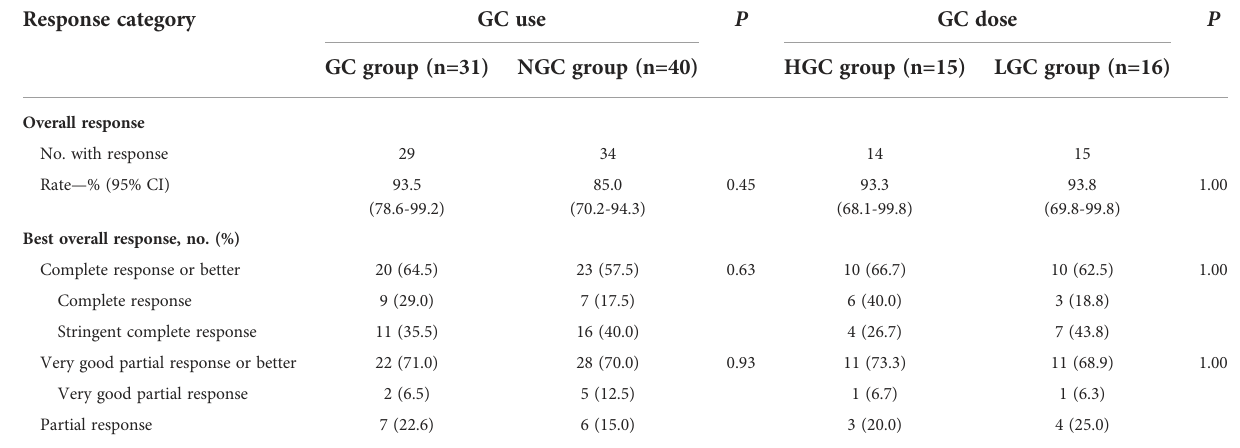
TABLE 2 Association between GCs and responses.